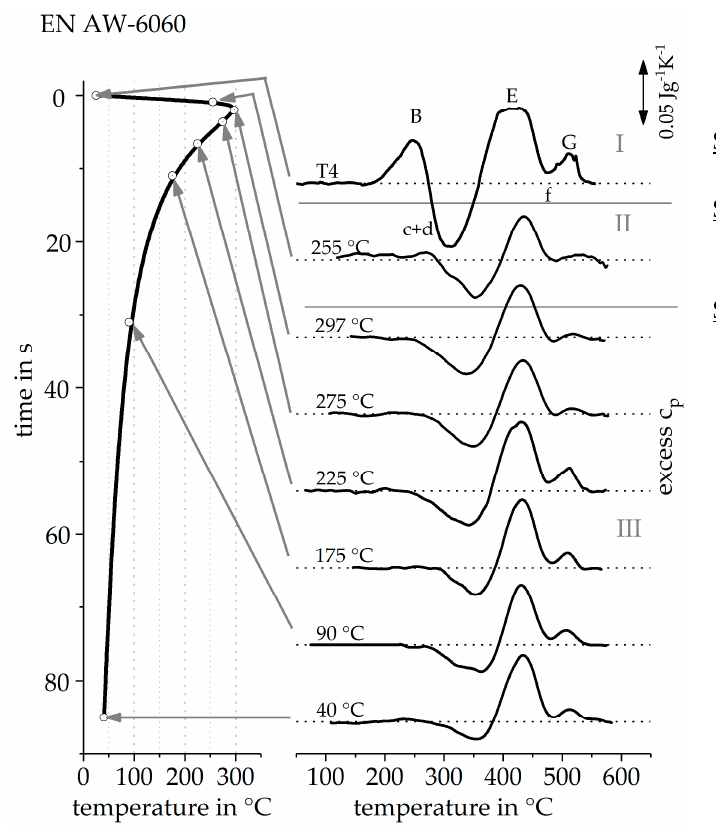
Figure 17. Reheating curves of the alloy EN AW-6060 T4 after an imitated laser short-term heat treatment.